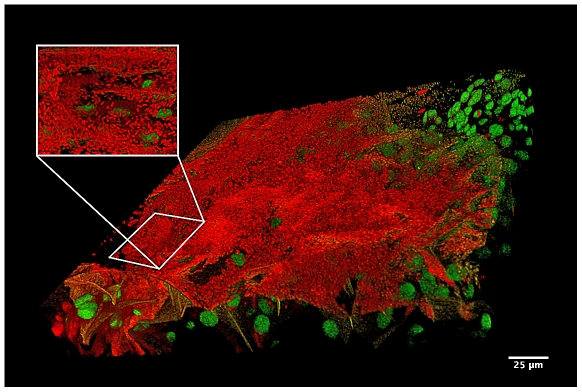

In vivo visualization of LAB biofilm.The red fluorescence shows live-stained bacteria in a LAB biofilm attached to a honey crop. The green fluorescence shows the nuclei of the honeybee crop cells. The visualized tissue shows a projection of 112 confocal z-sections (through a 37.6 µm z-depth, covering a xy-area of 246×246 µm).